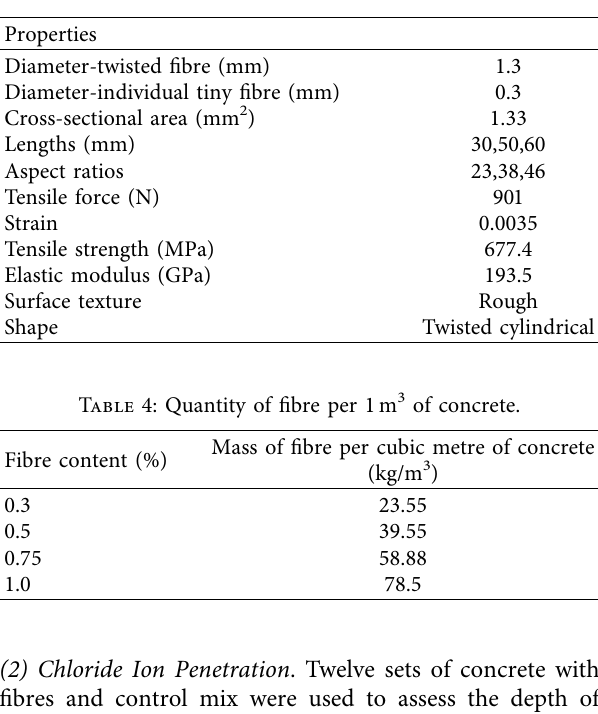
Figure 3: Characterization of waste tyre fibre. (a) Tensile test setup. (b) Region A . (c) 30mm fibre length. (d) 50mm fibre length. Table 3: Physical and mechanical properties of waste tyre steel fibres.